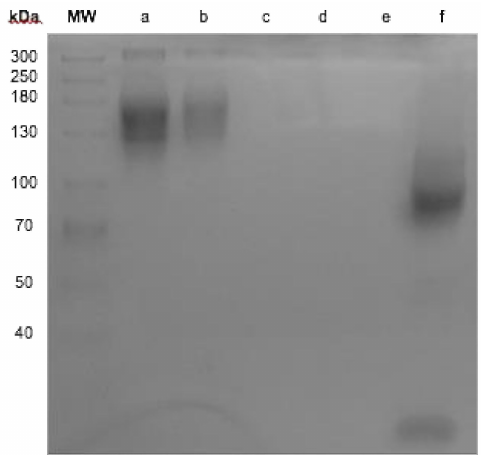
Figure 1. SDS-PAGE. Molecular weight size marker, ( a ) Nimotuzumab, ( b ) conjugate diethylenetriaminepentaacetic acid (DTPA)-nimotuzumab, ( c ) residual DTPA after purification, ( d ) DTPA, ( f ) nimotuzumab semi-reduction conditions.